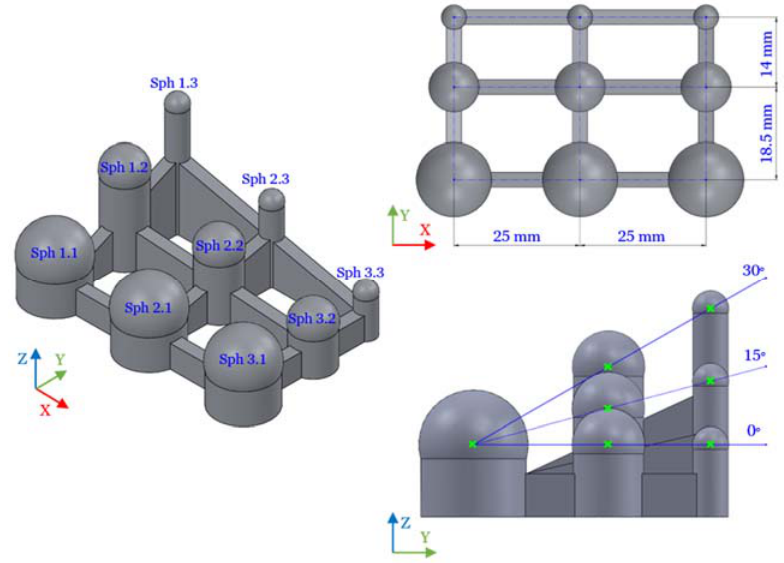
Figure 2. Test part CAD: sphere designations and design features.